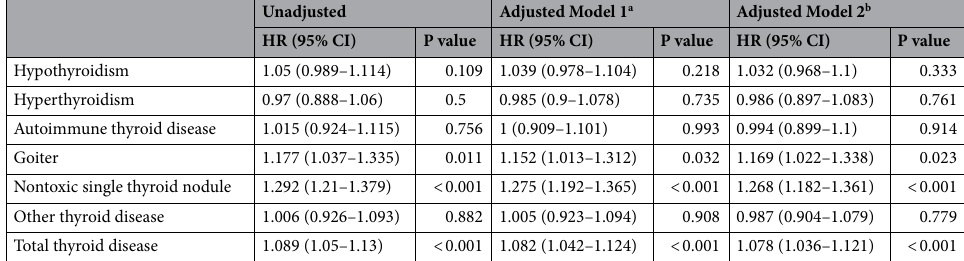
Table 3. Stratified Cox regression analysis of thyroid disease in patients with uterine fibroid from the HIRA data (after matching). CCI Charlson comorbidity index, CI confidence interval, DM diabetes mellitus, HIRA health insurance review & assessment service, HR hazard ratio, IBD irritable bowel syndrome, SES socioeconomic status, SLE systemic lupus erythematosus. a Each thyroid disease ~ Age per 5 years + Low SES + region + CCI + parity + menopause. b Each thyroid disease ~ Age per 5 years + Low SES + region + CCI + parity + menopause + hypertension + DM + dyslipidemia + SLE + IBD + Crohn’s disease +